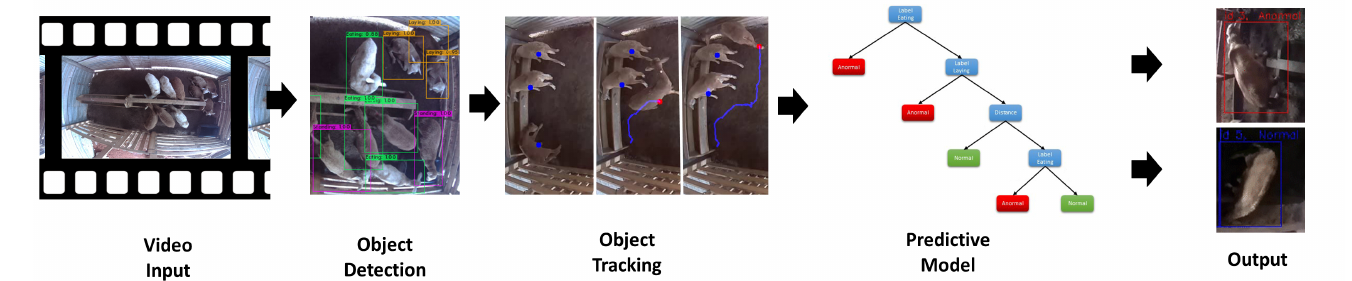
Figure 1. A diagram of the proposed